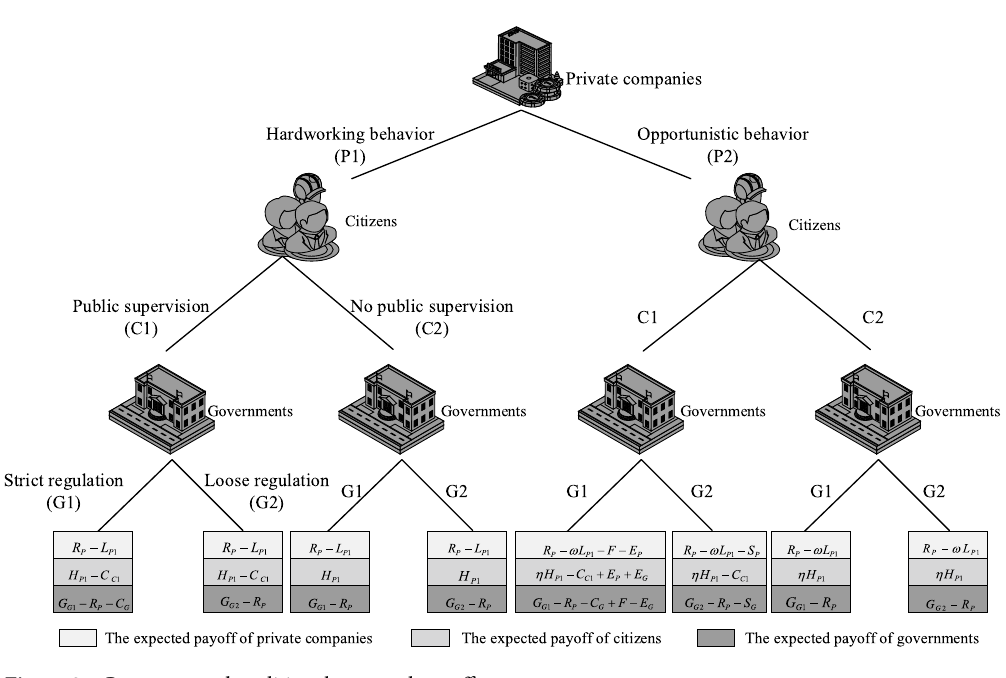
Figure 8. Game tree and traditional expected